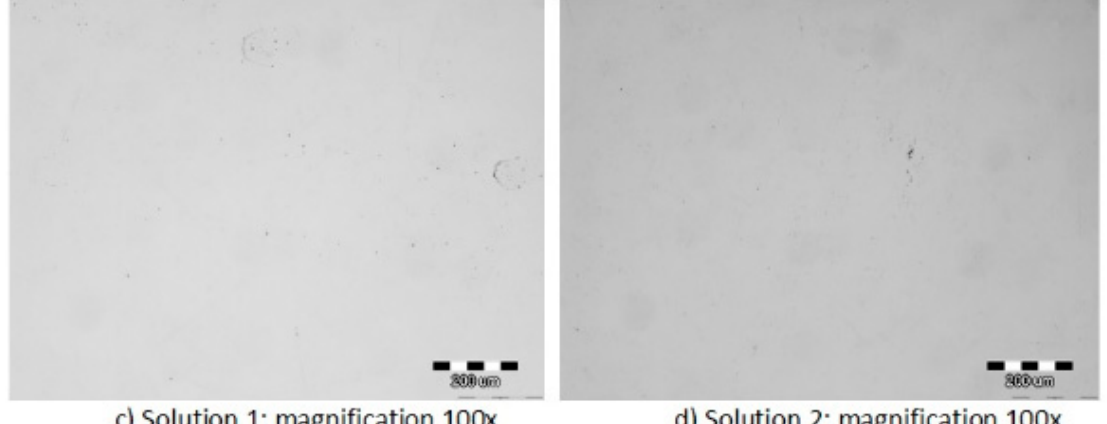
Figure 9. Microstructure of HTCS-130 hot work tool steel in: ( a ) water (magnification 50×, ( b ) water (magnification 200×), ( c ) solution 1 (magnification 100×), and ( d ) solution 2 (magnification 100×).